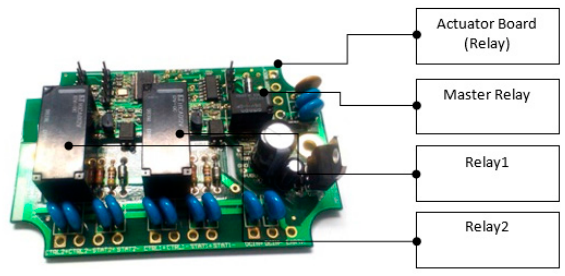
Figure 6. The wireless actuator mote.